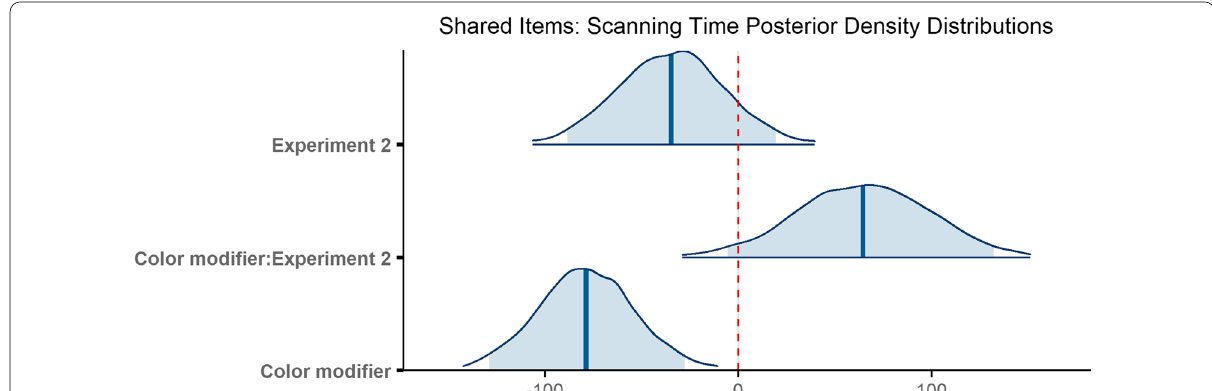
Fig. 14 Posterior density distributions for scanning time β parameter estimates for each level of the fixed effect relative to the reference level. Light blue shaded regions indicate the 95% credible interval and blue vertical lines indicate the mean of the distribution. The red vertical dashed line highlights 0 on the x axis. If the red line falls within the light blue shaded region, the estimate is not reliably different from zero and interpreted as